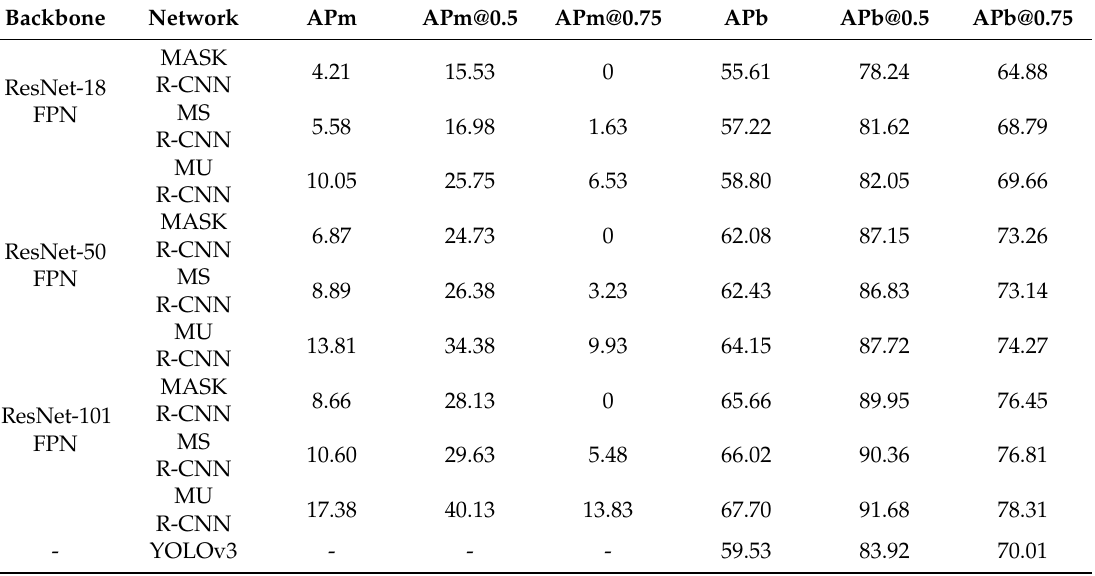
Table 5. Both detection and instance segmentation results on D pr dataset. APm denotes instance segmentation results and APb denotes detection